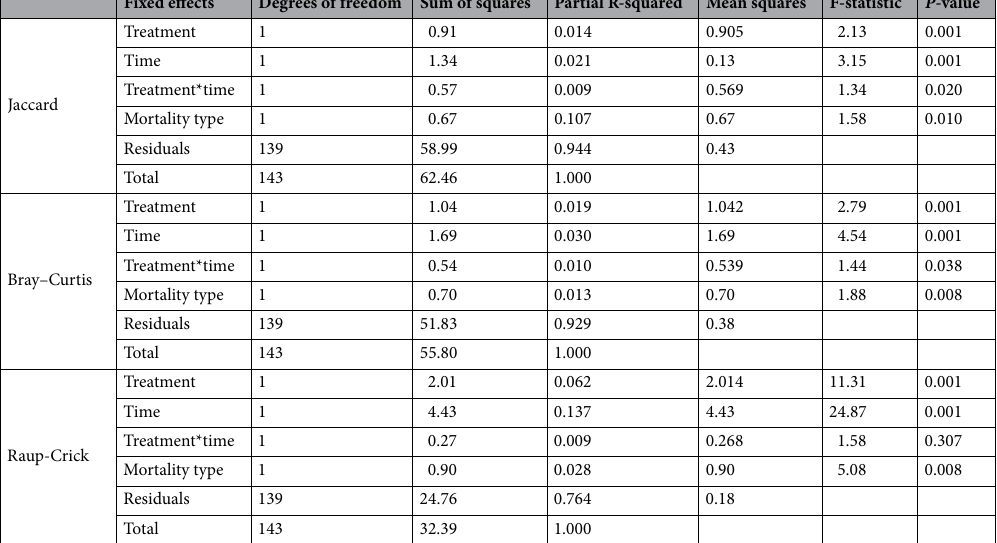
Table 2. Summary of PERMANOVA models of multivariate centroid position. Each subsection represents a distinct community dissimilarity metric (Jaccard, Bray–Curtis, and Raup-Crick respectively). Predictor variables included in the model are denoted in the Fixed effects column. All other columns detail model output, including F-statistics, partial R-squared, and p -values for each fixed